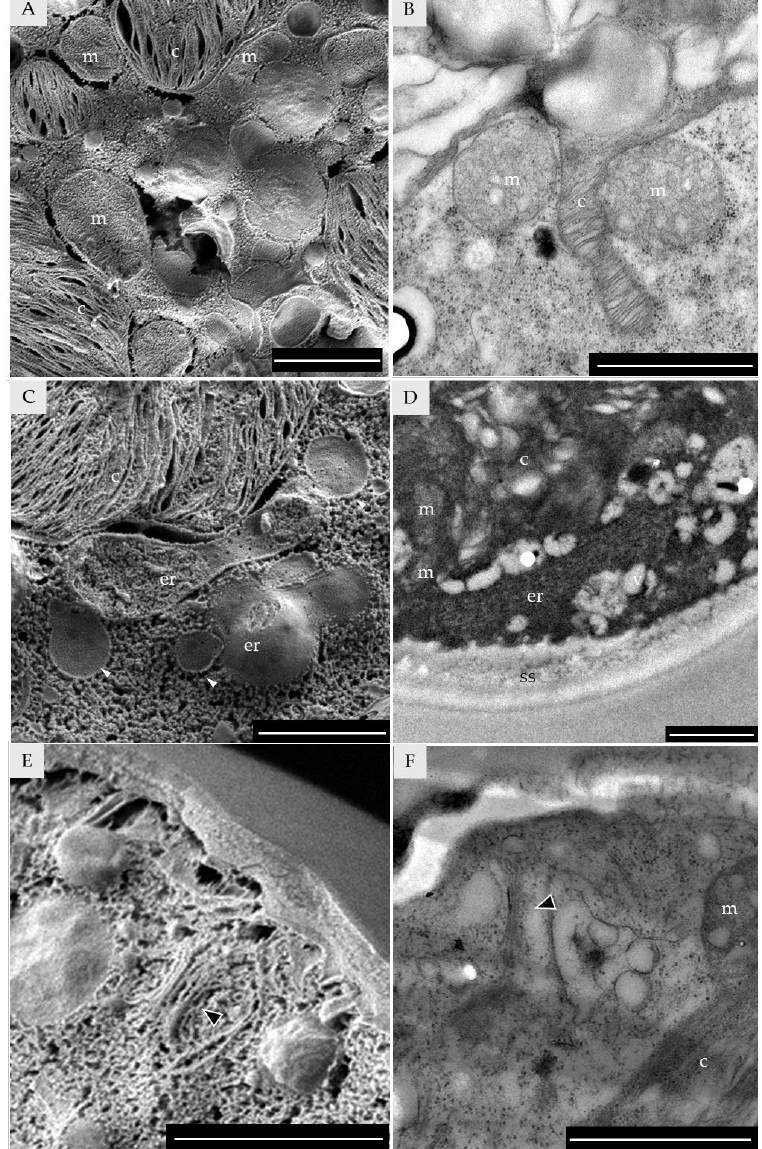
Figure 7. LTSEM ( A , C , E ) and TEM ( B , D , F ) of Trebouxia lynnae mitochondria and secretion system. ( A , B ) Mitochondria. ( C , D ) Fenestrated endoplasmic reticulum. ( E , F ) Dictyosome. Mitochondria (m), endoplasmic reticulum (er), secretion space (ss), and chloroplast (c) are indicated with letters. The dictyosome is indicated by a black arrowhead. Endoplasmic reticulum trafficking vesicles are indicated by white arrowheads. Scale bars: ( A – F ) 1 µm.